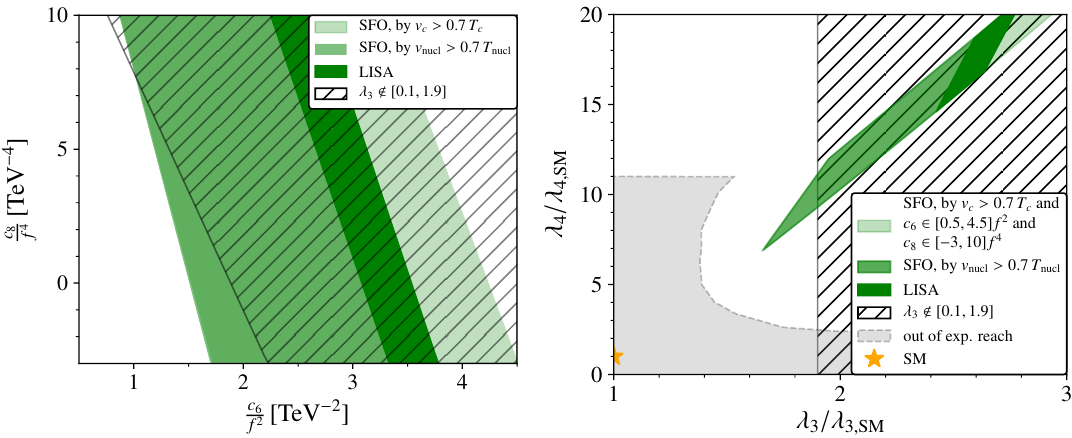
Figure 5 . Left panel) Region of (cid:12)gure 2 where the SFOEWPT is achieved accordingly to the & T & T criterion v T n instead of v T c c . The reaches of FCC-ee [43] and LISA [40] are also n displayed. Right panel) Allowed region from the left panel translated to the (cid:21) 3 =(cid:21) 3 ; SM { (cid:21) 4 =(cid:21) 4 ; SM plane together with the future experimental sensitivities